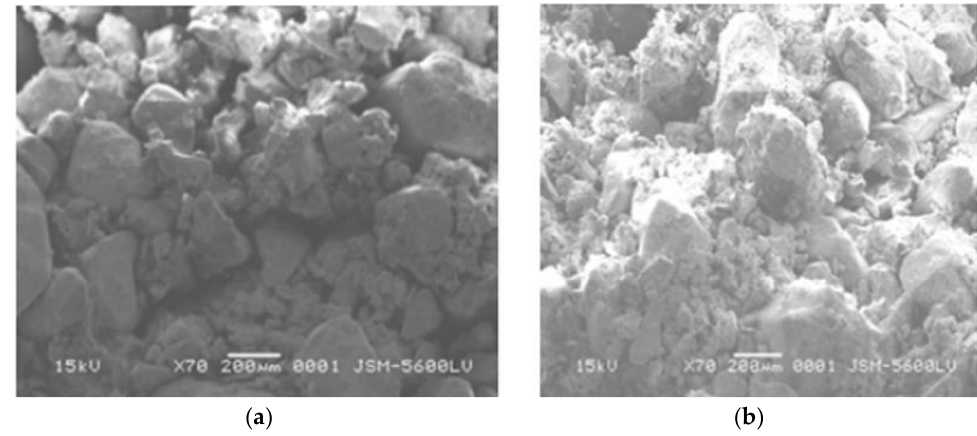
Figure 12. Electron microscopy of ( a ) natural soil — packaging, and ( b ) soil – sludge mixture — Quartz grains bonded with silts, clays, and soil – sludge organic matter. Finally, double oedometer tests were carried out with soil and soil – sludge mixtures compacted with a dry specific weight of 15.0 kN/m 3 and 17.0 kN/m 3 . Figures 13 – 16 present the void index versus the vertical consolidation stress, and the specific volumetric strain versus the vertical consolidation stress, obtained in tests on soil samples in natural (constant) and flooded soils (using distilled water as flood liquid).